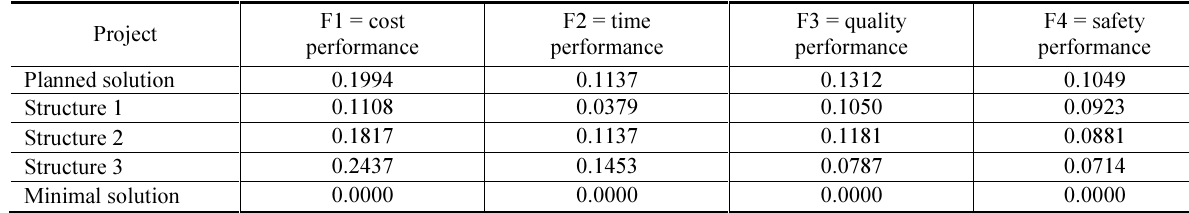
Table 7. Weighted matrix of normalized values